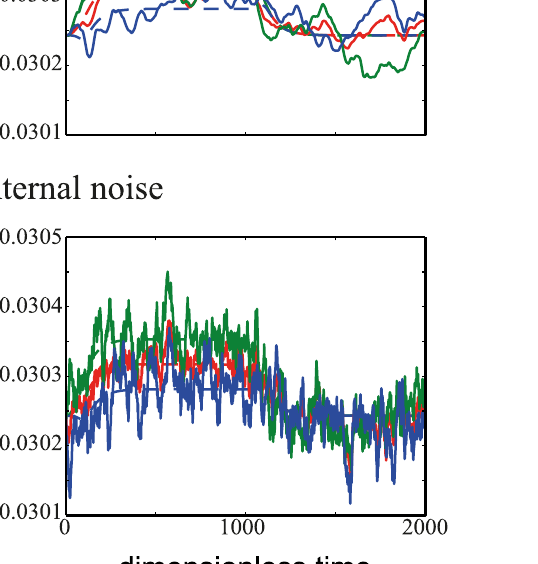
Fig 8. Dynamics of the average level of protein C (red), level of protein C at the front (green) and back (blue) for noise in the external chemoattractant gradient (top) and internal signaling pathway (bottom). Dotted lines are the average level of protein in the absence of any noise. Values used are β = 1.0, D 0 and ν = 0.25